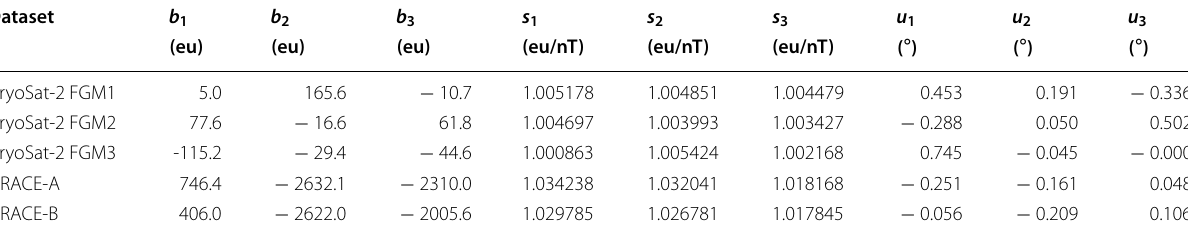
Table 7 Mean values of the calibration parameters for each platform magnetometer dataset. The time-series are shown in Fig.